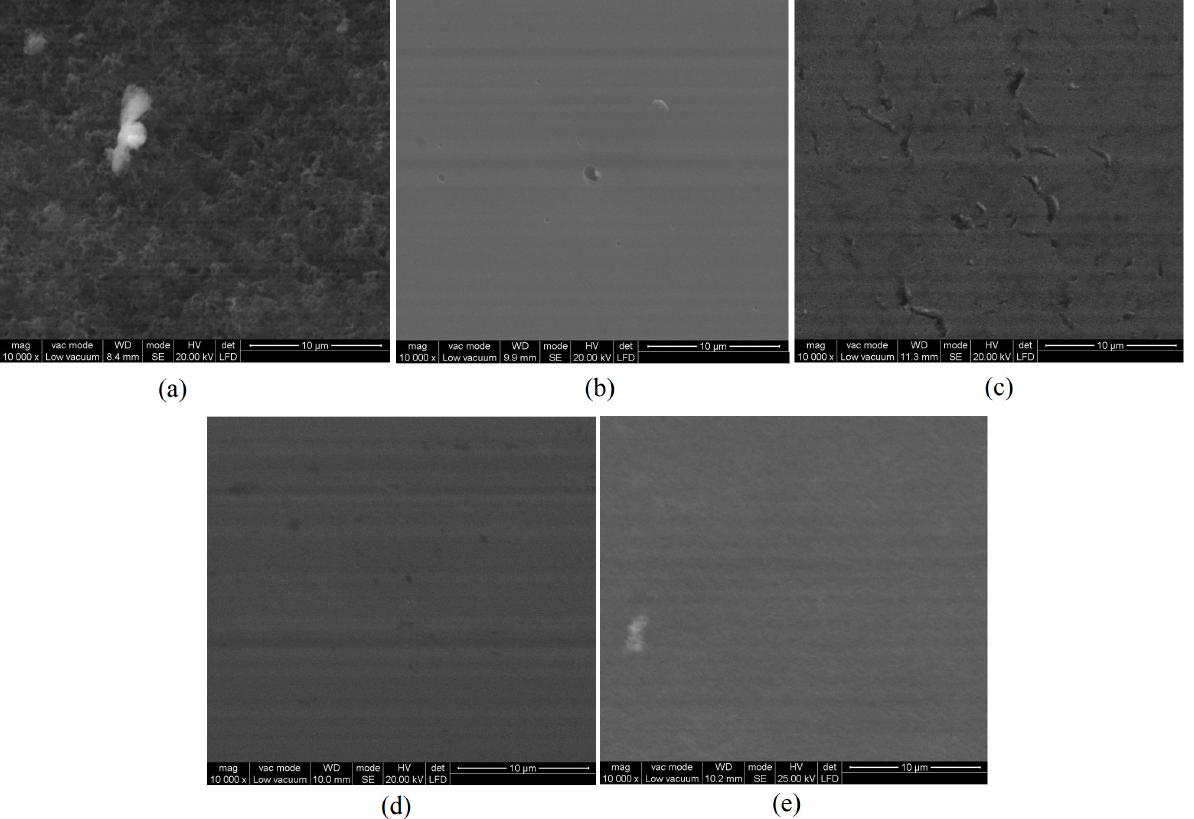
Figure 5: Recorded SEM micrographs for (a) PANI-EB, (b) PSSA, PSSA-PANI (c) 1:1, (d) 2:1, (e) 3:1.